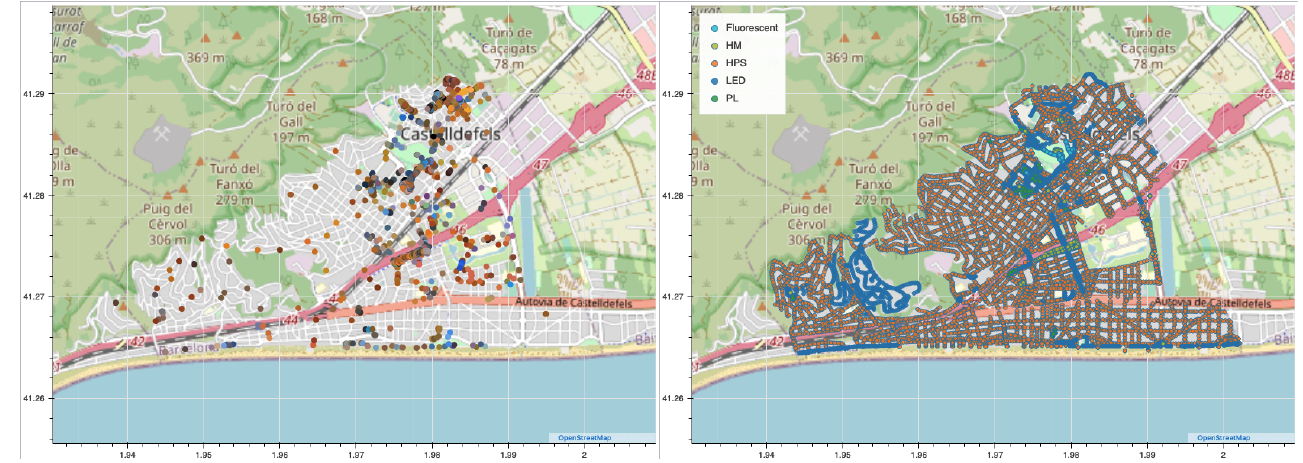
Figure 4. ( left ) Spatial distribution of the NightUp dataset for Castelldefels. ( right ) Spatial distribu- tion of the streetlights as depicted in the dataset from the city